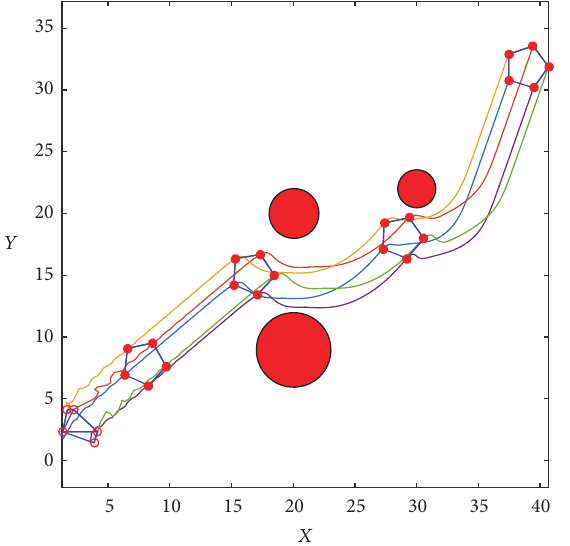
Figure 8: Multiagent robot trajectories with multiple size multiple obstacles.